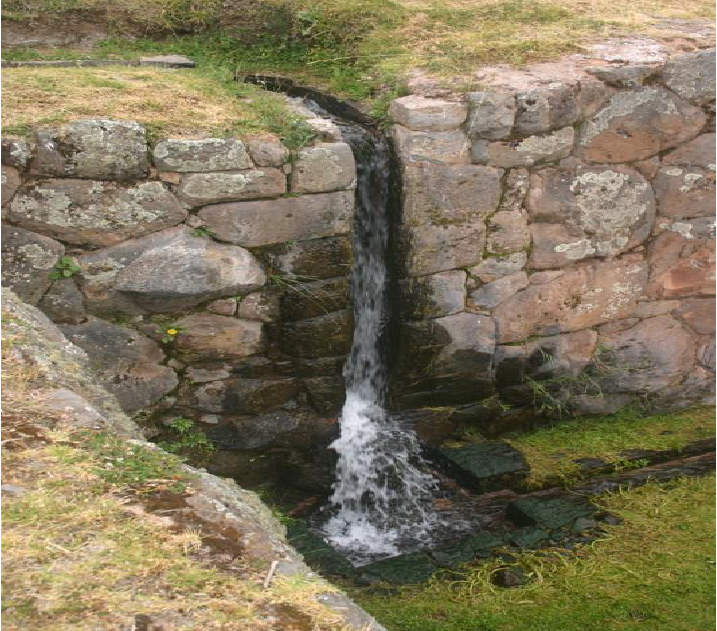
Figure 4. Drop structure conveying water from a higher to lower agricultural platform. Typically, a portion of the received water into the lower platform channel was distributed laterally into a channel network to provide irrigation water for the next lower platform; excess water was channeled to an easternmost drainage channel. This drop structure is associated with the base of one of the lower platforms shown in Figure 1. (Photo by C. Ortloff).